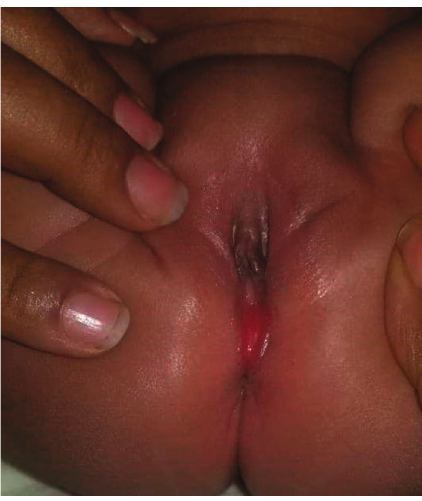
Figure 1: Physical examination fi nding showing the perineal